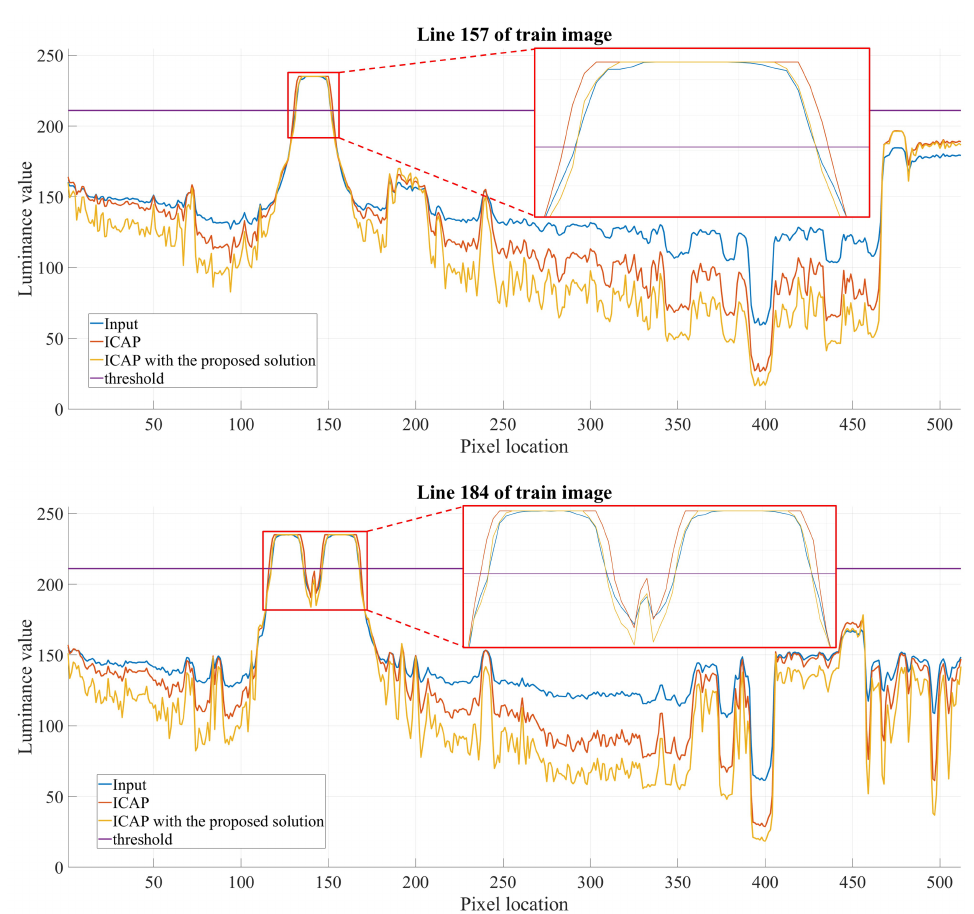
Figure 9. Result of applying the proposed atmospheric light compensation scheme.